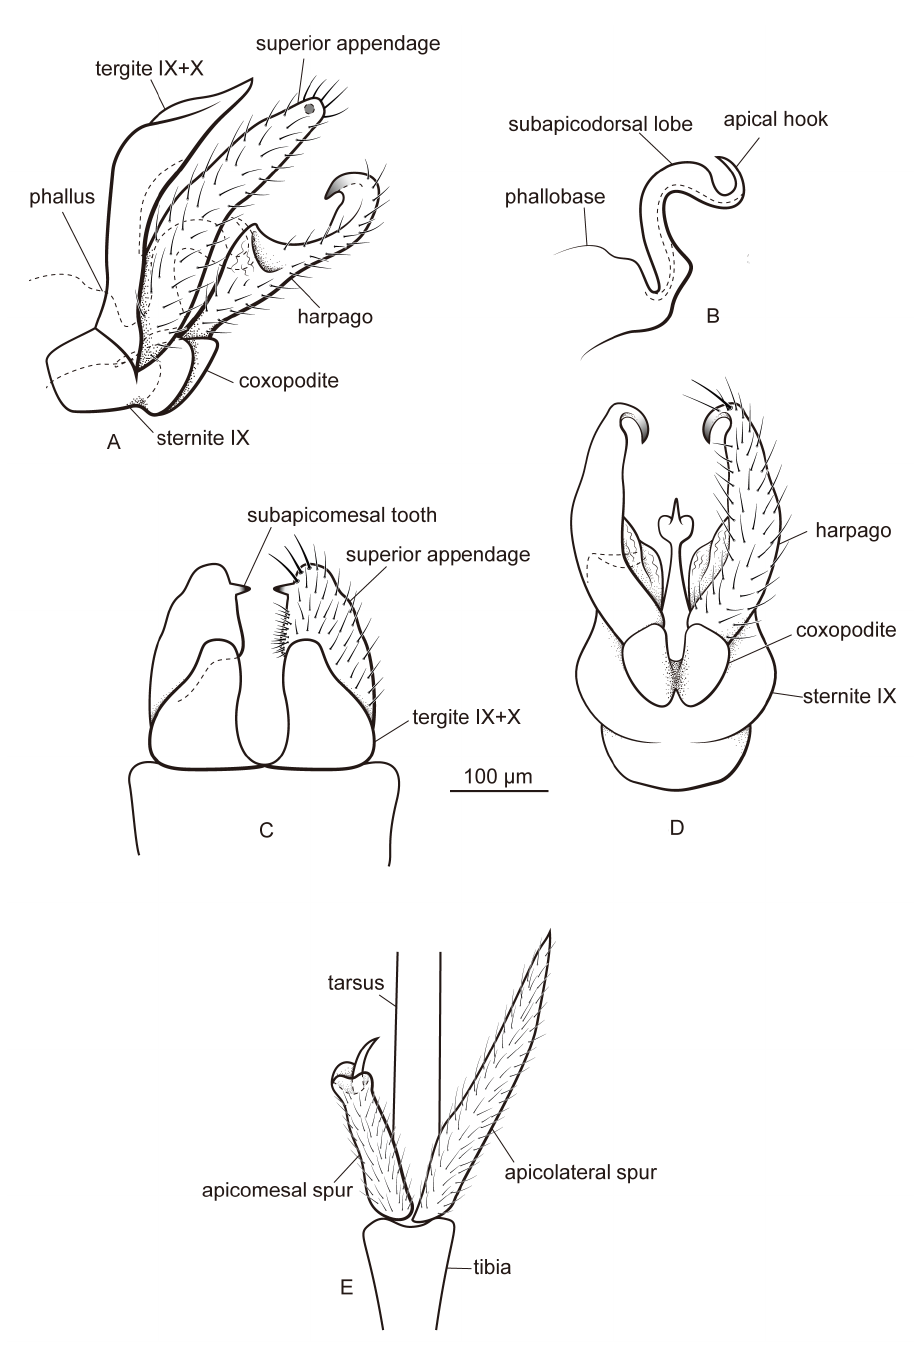
Figure 4. Male of Metalype truncata sp. n. A genitalia, left lateral B phallus, left lateral C genitalia, dorsal D genitalia, ventral E apical spurs of right hind leg,